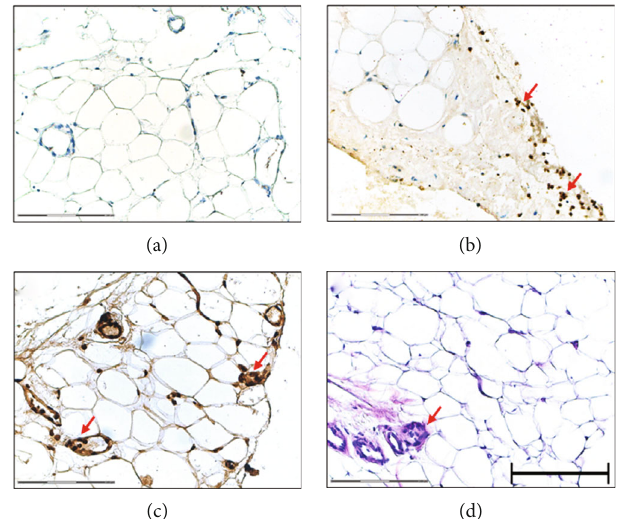
Figure 3: RAGE and HMGB1 expression on in fl ammatory in fi ltrates in GO tissues. (a) Isotype negative control staining of GO tissue. (b) RAGE expression on in fl ammatory in fi ltrates (arrows). (c) HMGB1 expression on in fl ammatory in fi ltrates (arrows). (d) H+E staining of GO tissue. Bar =150 μ